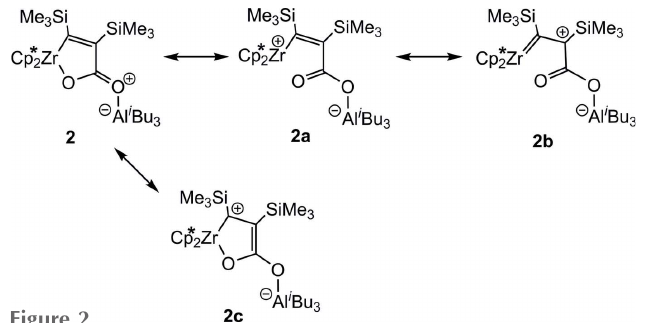
Figure 2 Possible resonance structures of complex 2 .